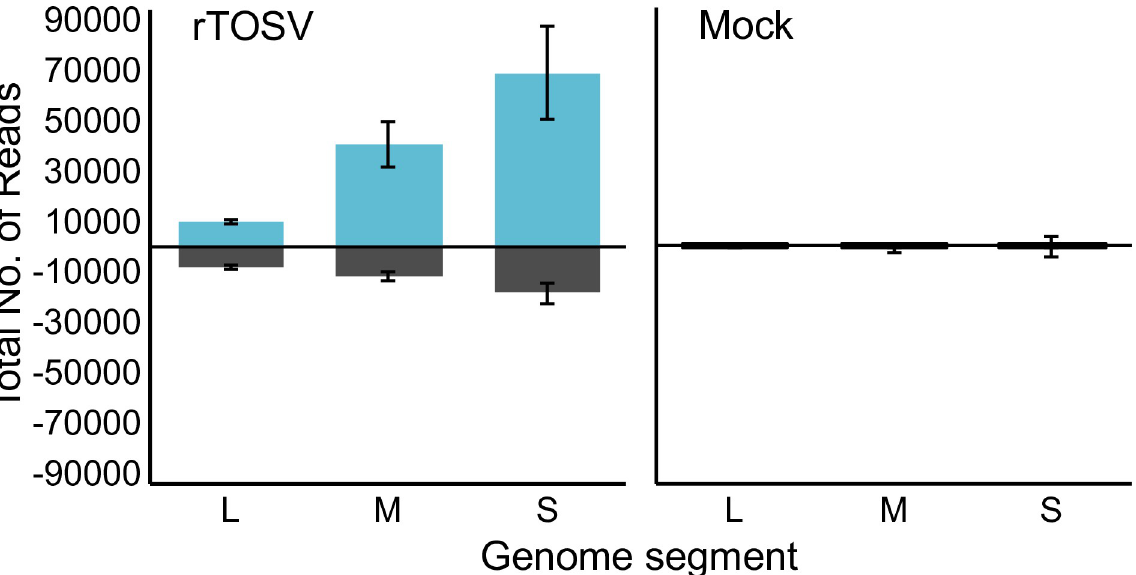
Fig 7. Overall coverage of small RNAs mapping to rTOSV segments. The PP9ad cell line was infected with rTOSV at a MOI of 10 PFU/cell or mock infected. At 3 d.p.i., cells were harvested and small RNAs were isolated and the overall distribution of small RNA sequences mapping to the genomic (black, negative reads) or antigenomic (blue, positive reads) viral S, M and L RNA segments. Data presented as mean ± SD from three independent experimental repeats.